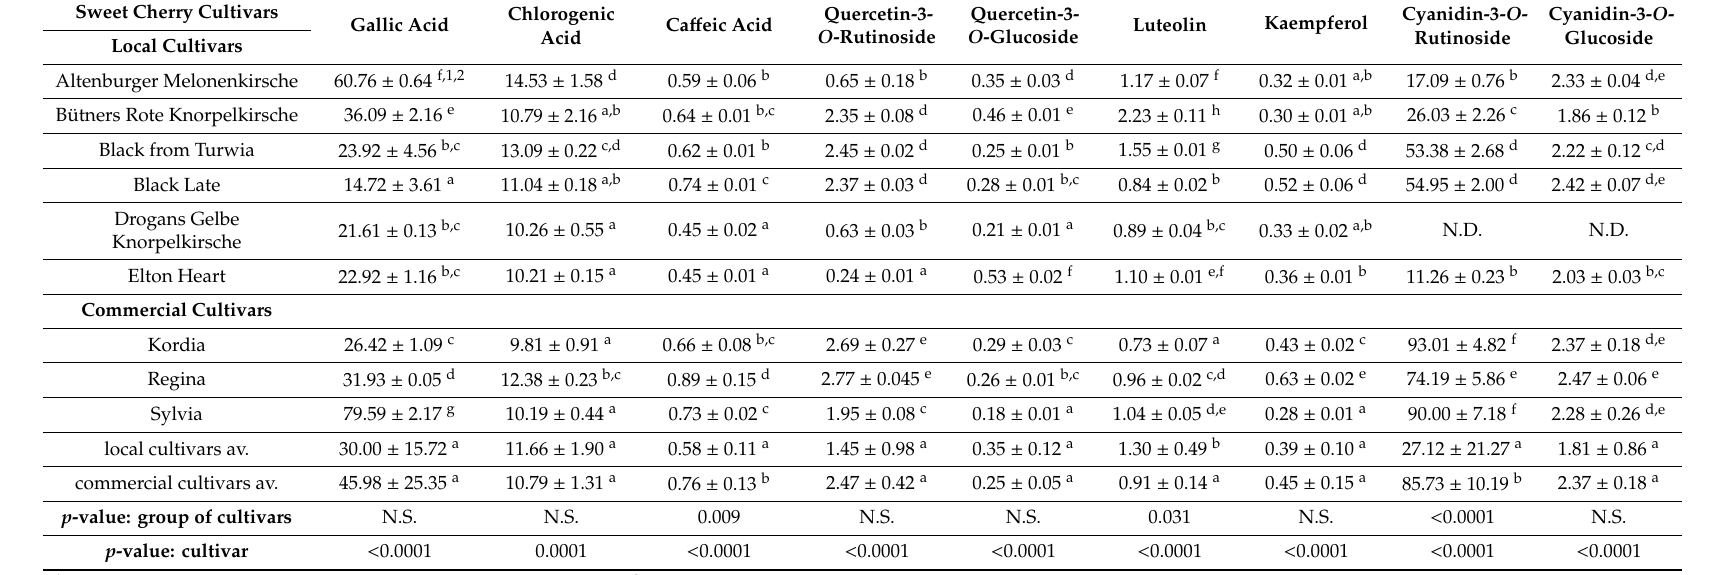
Table 5. The content of individual phenolic compounds (in mg 100 g − 1 FW) in sweet cherry fruit harvested in 2013. Sweet Cherry